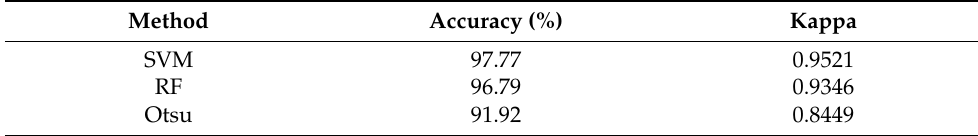
Table 4. Accuracy comparison of different methods using the testing samples.